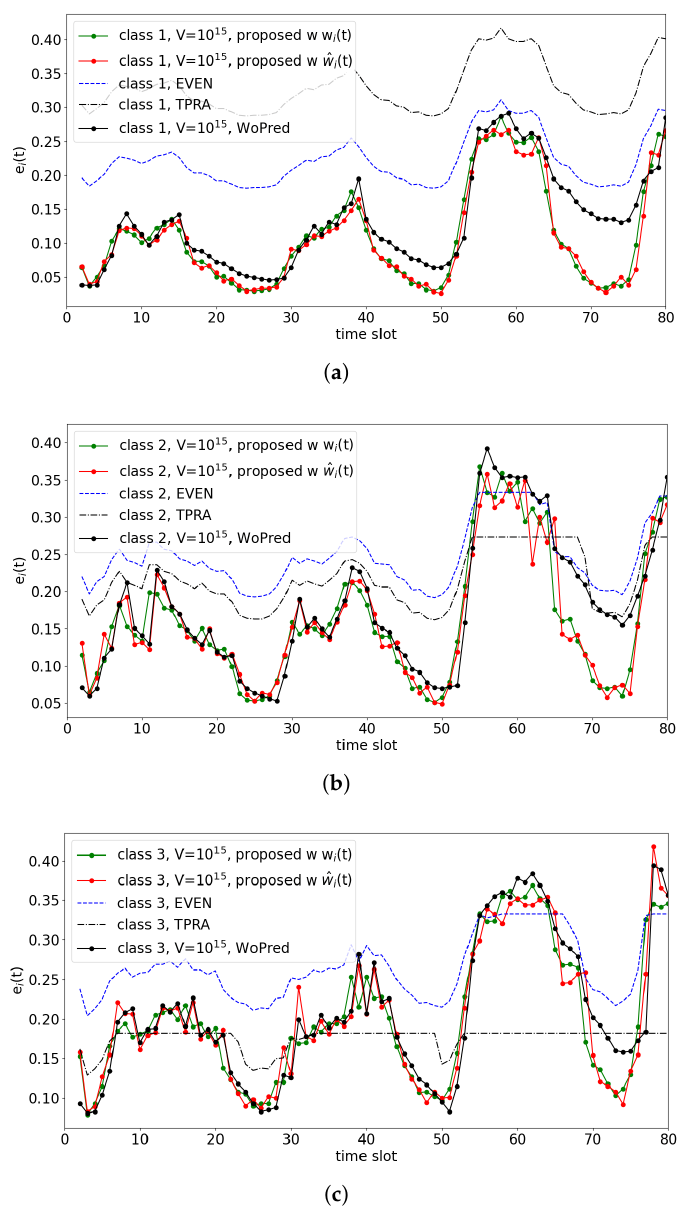
Figure 5. Comparison of e i ( t ) for three classes. ( a ) e 1 ( t ) over time, ( b ) e 2 ( t ) over time, and ( c ) e 3 ( t ) over